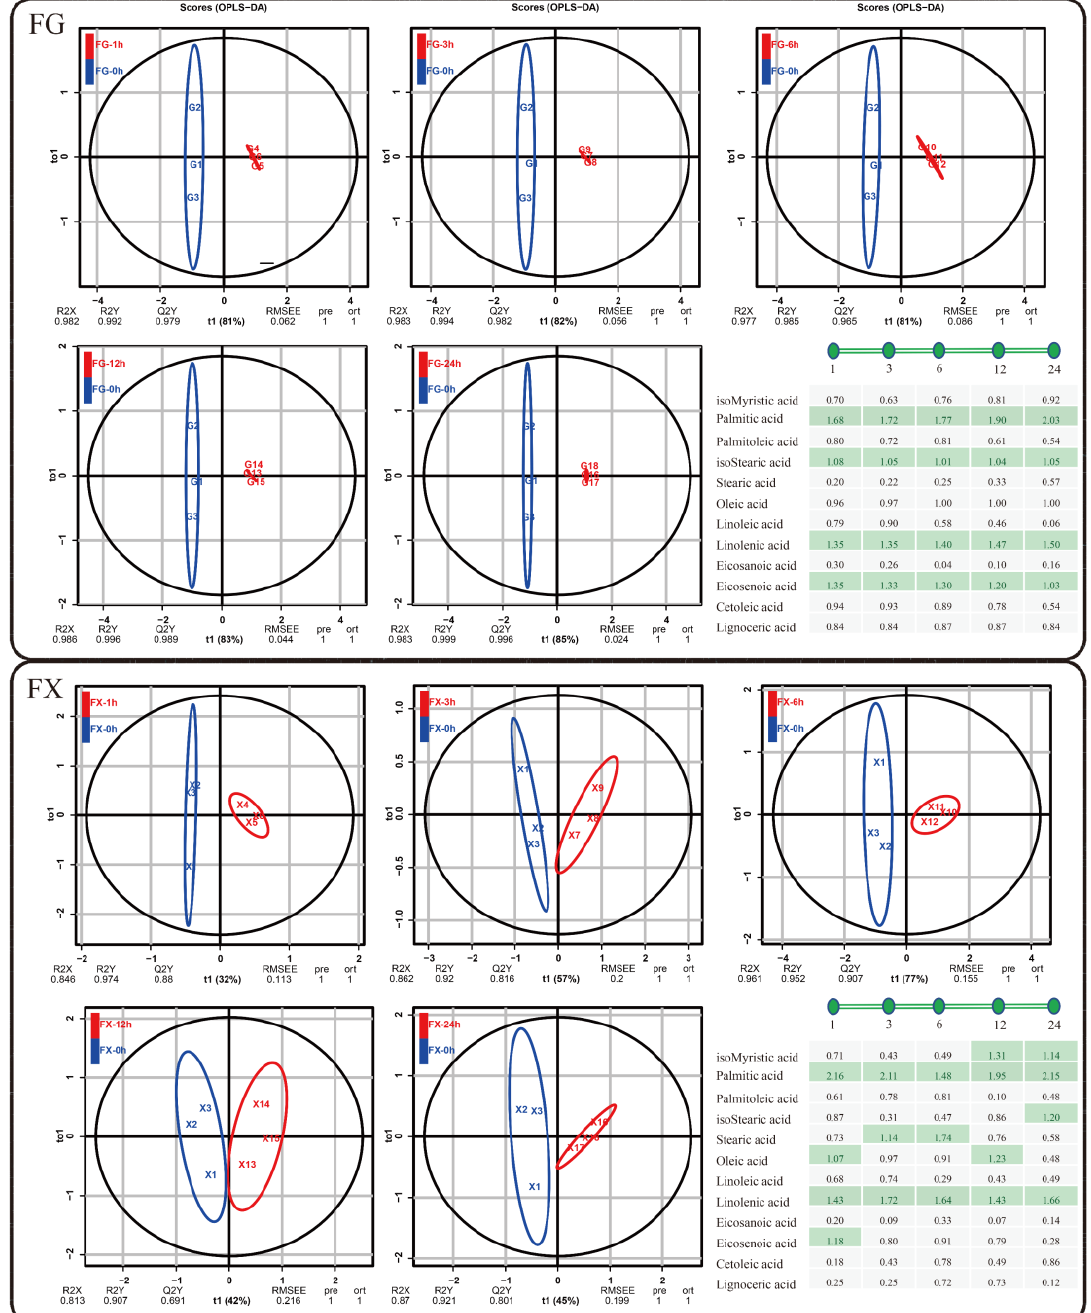
Figure 4. Orthogonal partial least squares discriminant analysis (OPLS-DA) and variable im- portance in projection (VIP) of fatty acid composition for ( FG ) and ( FX ) samples under low temper- ature.